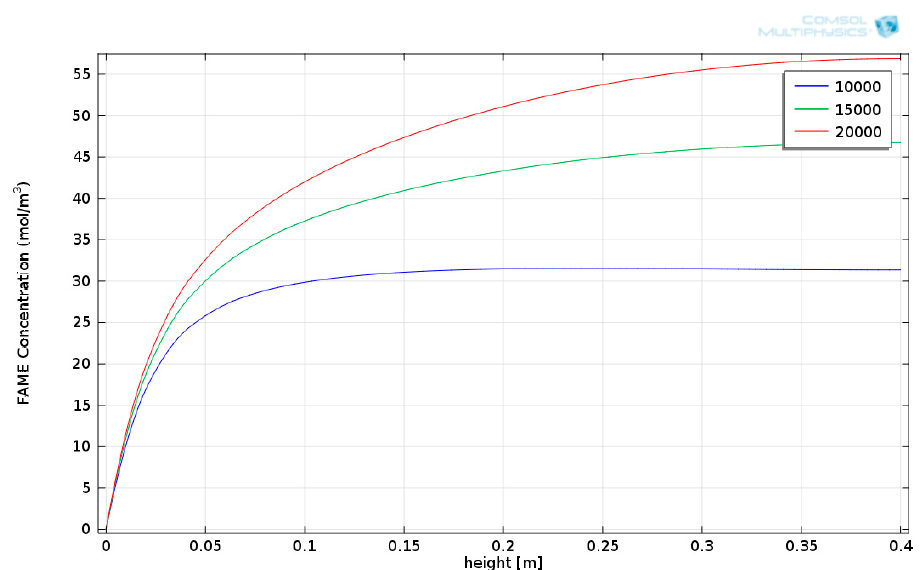
Figure 11. Axial plot of the FAME concentration along the esterification reactor height for phenyl- naphthalene liquid at temperature of 50 °C.